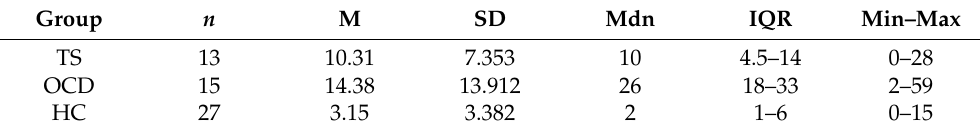
Table A4. Scores in the Beck Depression Inventory-II (BDI-II) in groups. Abbreviations: HC, healthy